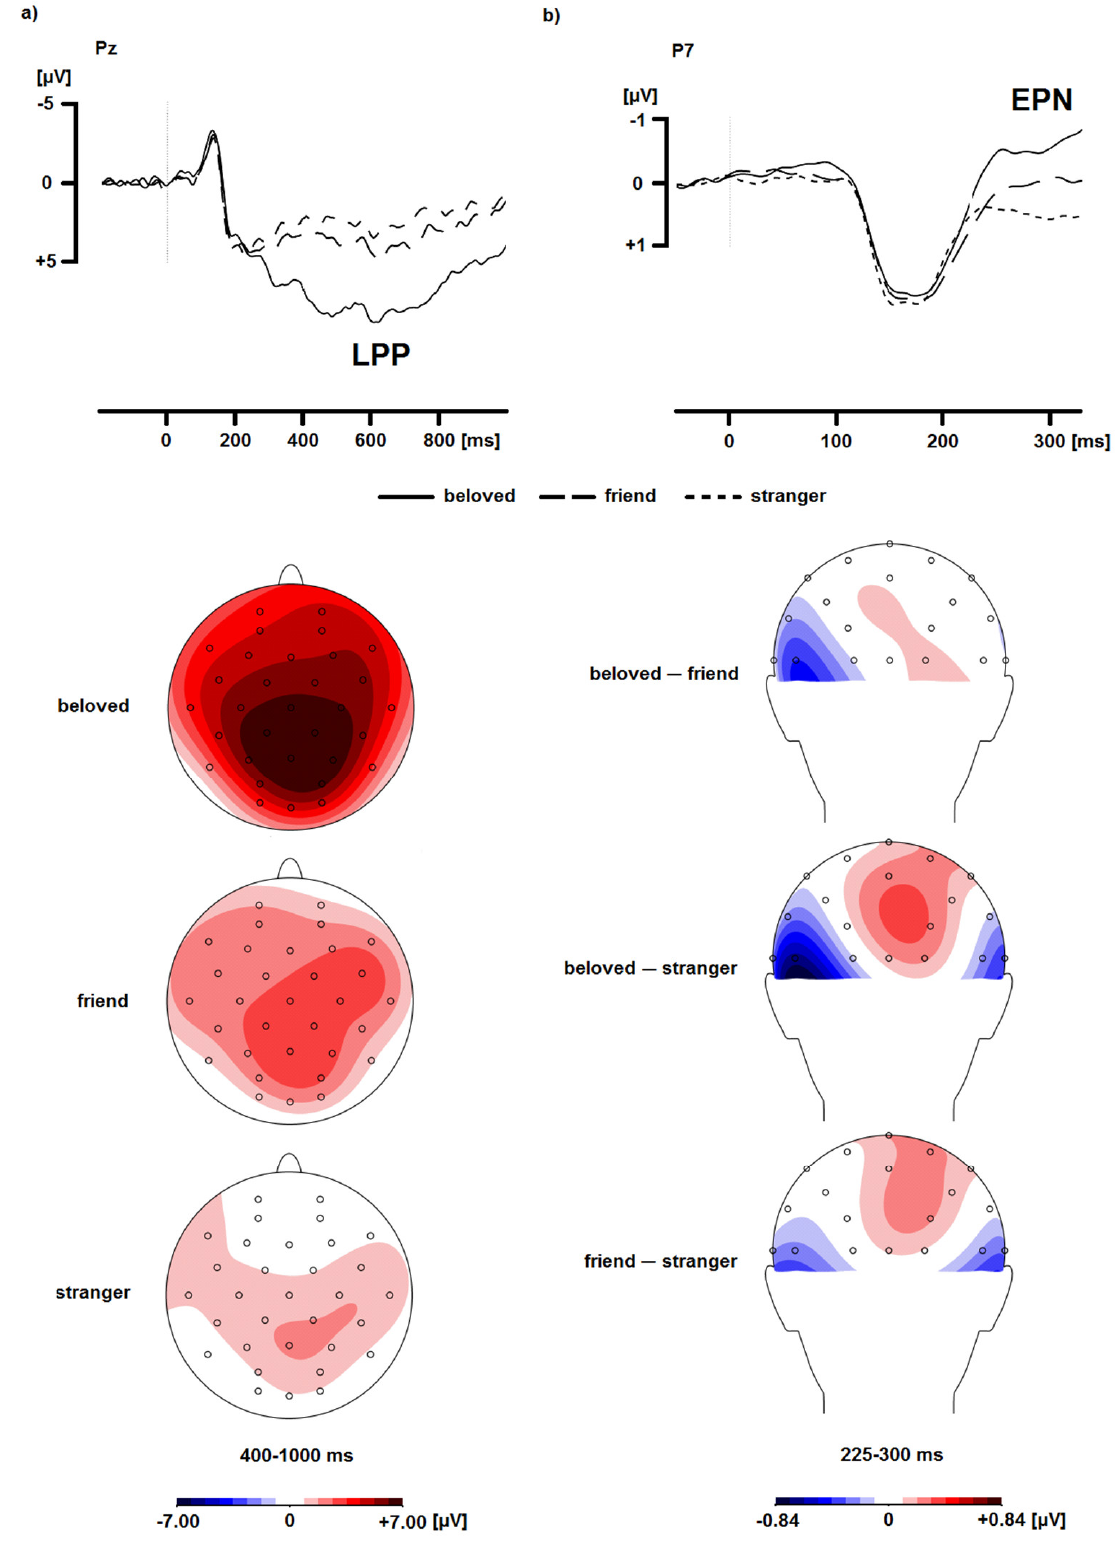
Figure 1. Examples of the enhanced LPP ( panel a ) and the EPN ( panel b ) in response to the beloved, adapted from [50]. As is common in ERP figures, positive is plotted downward. Because the EPN is a relative difference, scalp topography effects are